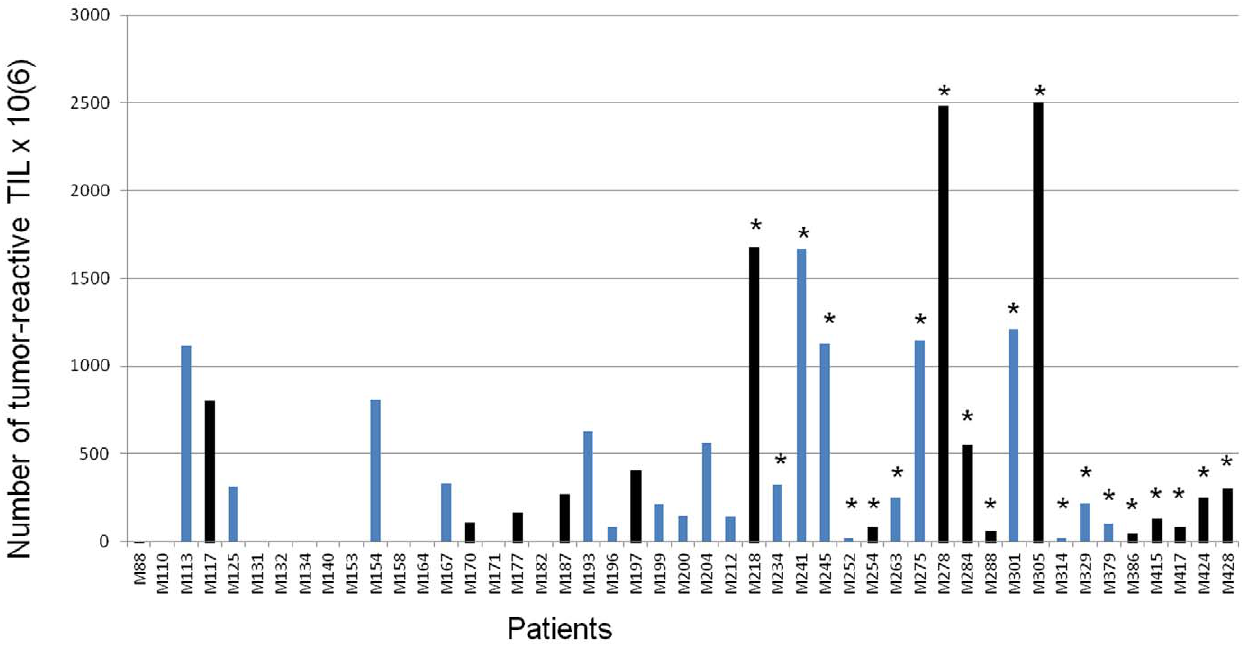
Figure 2. Number of tumor-reactive TIL injected in 47 patients. Black bars indicate relapse-free patients. * Indicates patients with only one melanoma-metastatic lymph node (early stage III patients).